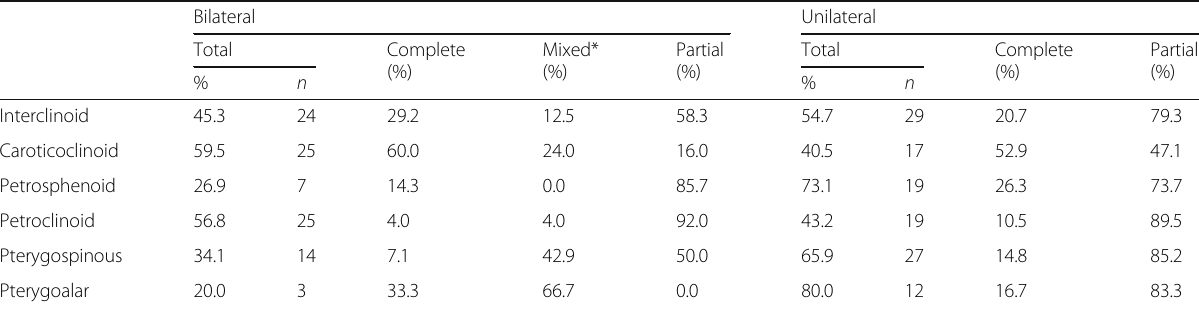
Table 3 Characteristics of mineralised ligaments Bilateral